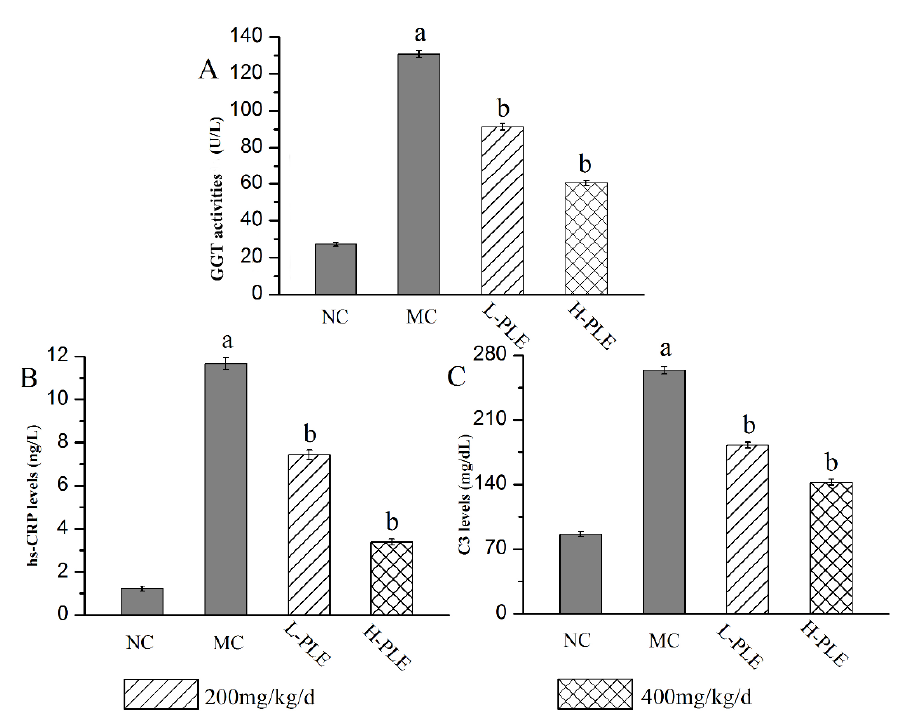
Figure 6. Effects of PLE on improving lung functions. ( A ) GGT activities, ( B ) hs-CRP levels, and ( C ) C3 levels. The values were reported as the Mean ± SD (n = 10 for each group). (a) p < 0.05, compared with NC group; (b) p < 0.05, compared with MC groups. hs-CRP: hypersensitive C-reactive protein; GGT: Glutamyl transpeptidase. NC: Normal control; MC: Model control; L-PLE: low dose group; H-PLE: high dose group.